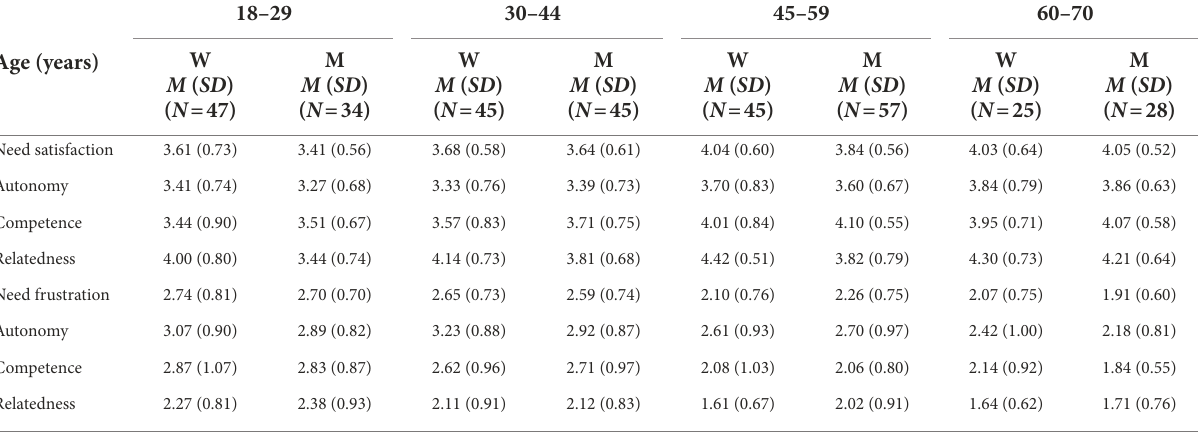
TABLE 6 Norm scores and sample sizes for need satisfaction and frustration for women and men by